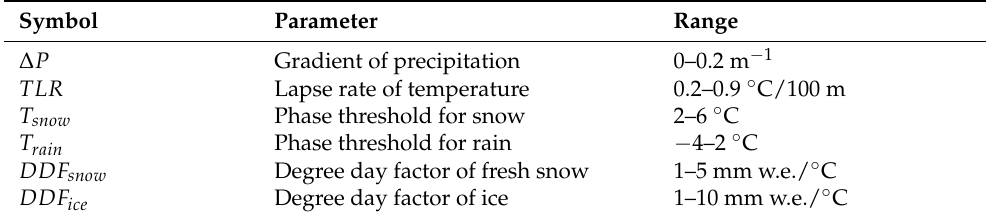
Table 1. List of model parameters, their initial ranges.